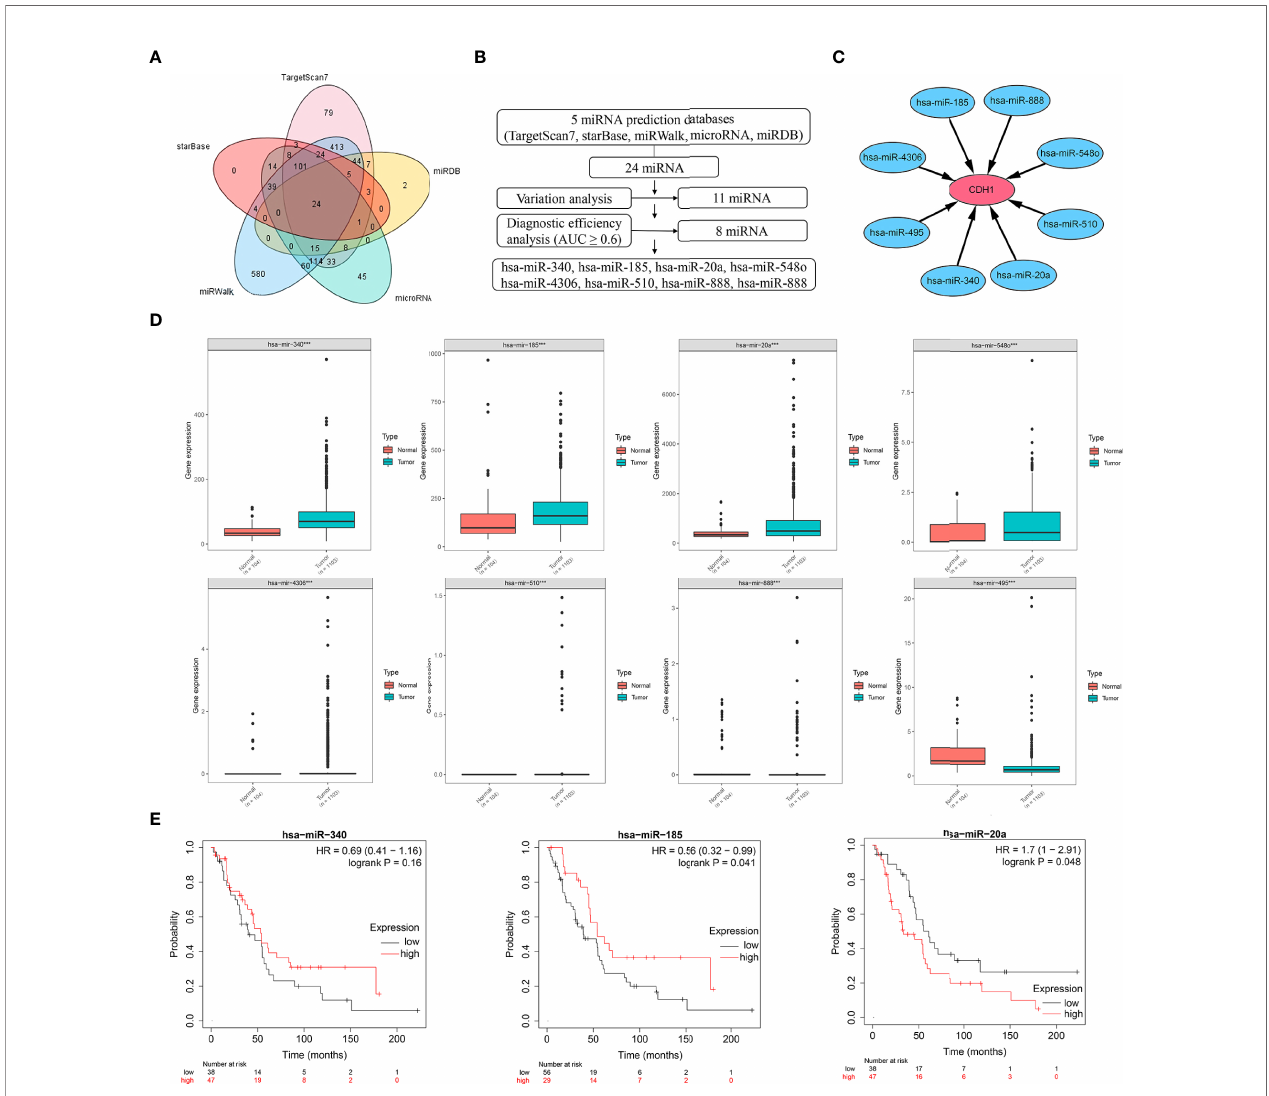
FIGURE 3 | Expression and prognostic signi fi cance of miRNAs targeting CDH1. (A) Venn diagram of potential miRNAs predicted to regulate CDH1 from a total of fi ve databases: Targetscan7, miRDB, microRNA, miRWalk, and starBase. (B, C) Expression and diagnostic ef fi ciency analysis of miRNAs regulating CDH1. (D) TCGA database analysis of gene expression of miRNAs regulating CDH1. (E) Kaplan-Meier plotter database analysis of the signi fi cance of miR-340, miR-185, and miR-20a expression in breast cancer prognosis. *** P <